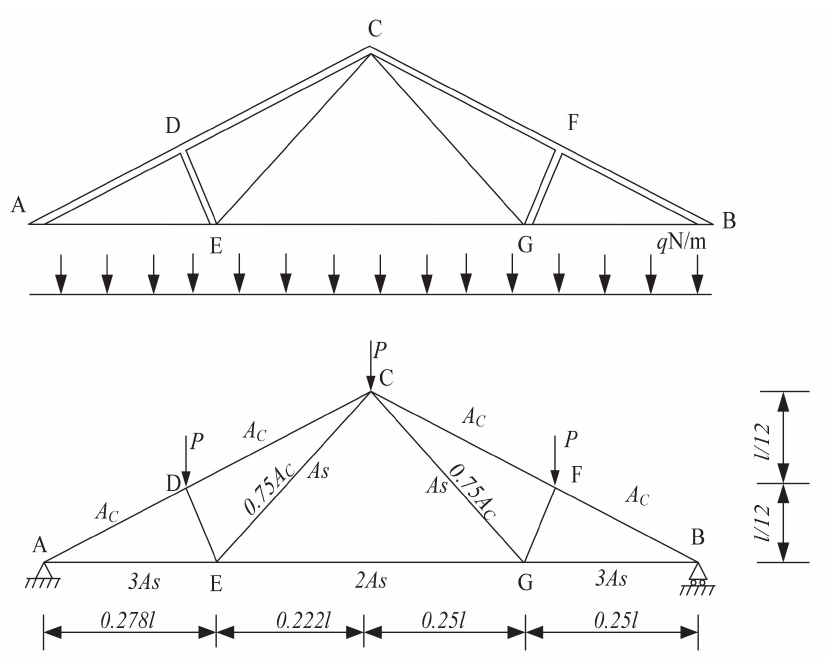
Figure 6. Roof truss model.